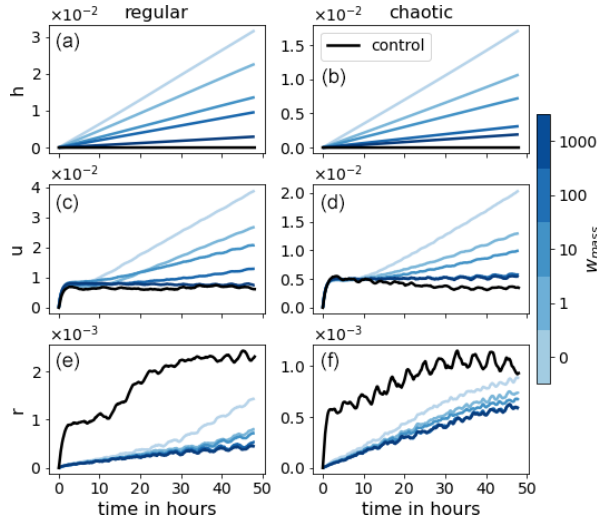
Figure 10. Same as Fig. 9 but for the MSE.